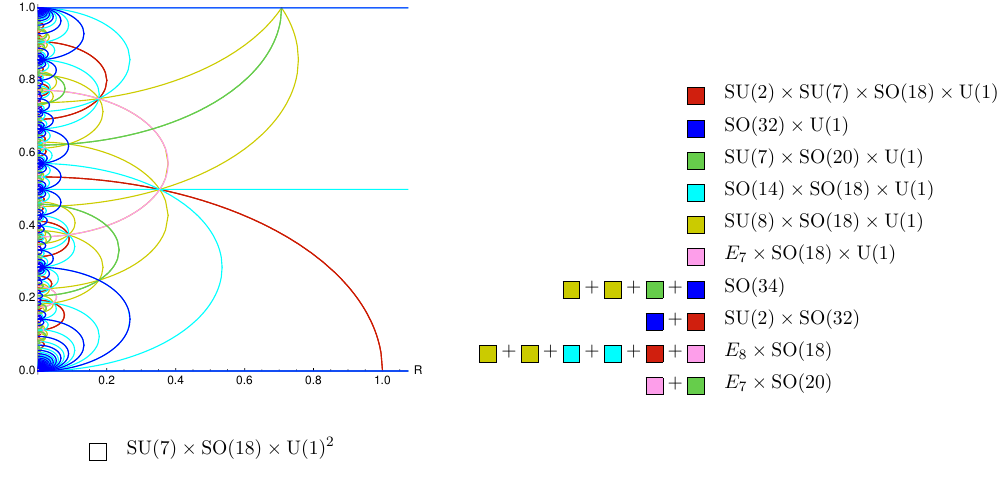
Figure 14. SO(32) heterotic with Wilson line A I = (( A ) 7 ; 0 9 ).